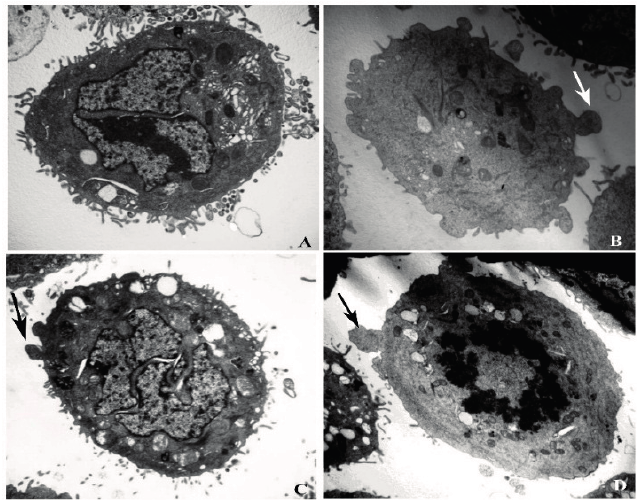
Figure 3. Apoptosis of HT-29 cells after treatment of X12-PG. ( A – D ) were respectively treated with 0, 400, 800, 1600 μ g/mL X12-PG for 48 h. HT-29 cells were observed by TEM (×6000). The arrows indicate the apoptotic